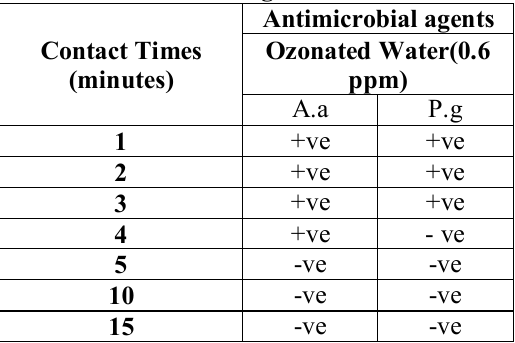
Table 2: Efficiency of ozonated water at different exposure times on A.a and